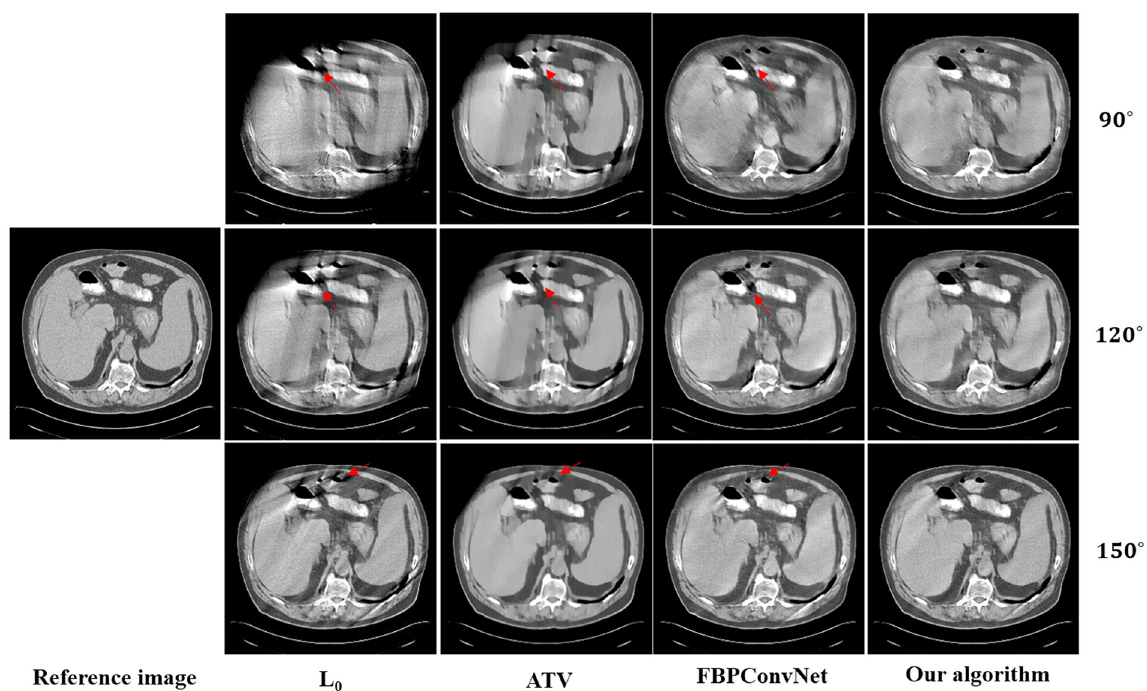
Fig 6. The reconstructed results of the abdomen image. The image on the first column is the reference image. The subsequent columns are the results reconstructed using L0 method, ATV method, FBPConvNet method and our algorithm. The images from top to bottom in each row are the results reconstructed for the scan ranges [0˚, 90˚], [0˚, 120˚] and [0˚, 150˚], respectively. The location of red arrows present some obvious artifacts, and the display window is [800 1200]